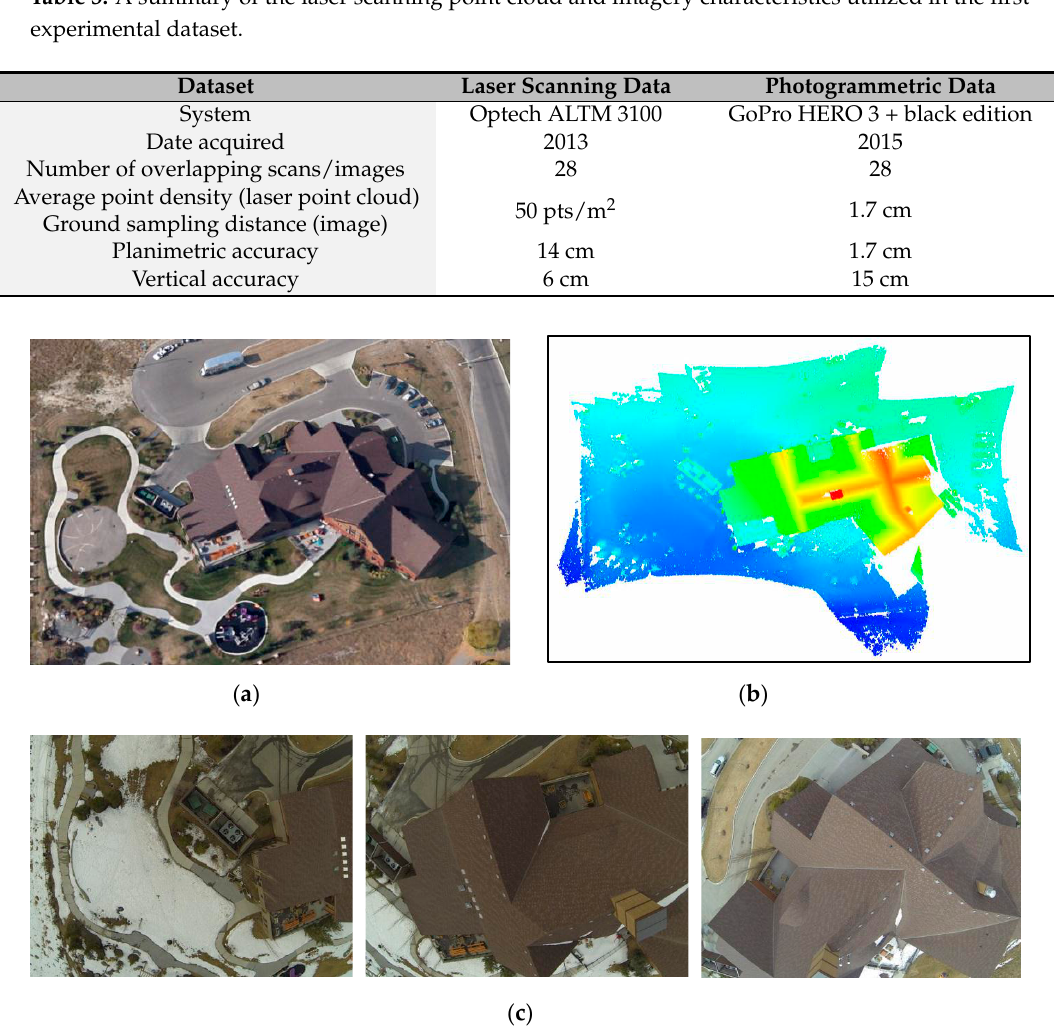
Figure 26. ( a ) An overview of the building of interest (located in Calgary, AB, Canada) from Google Earth; ( b ) laser scanning point cloud colored according to height; and ( c ) three of the captured images over the same building.